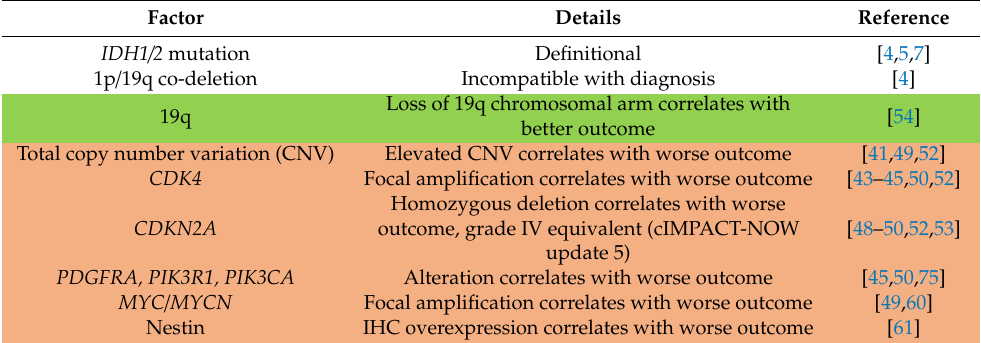
Table 1. Prognostic factors in IDH-mutant histologically lower-grade